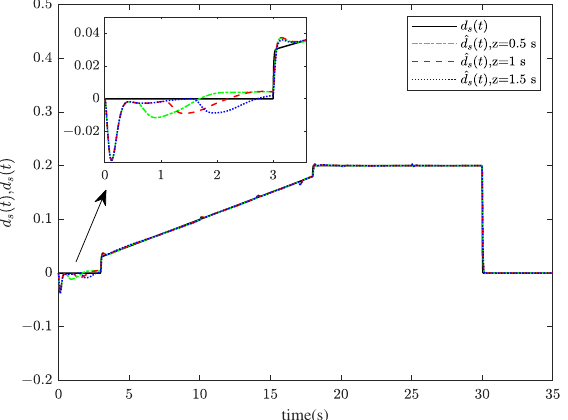
Figure 8. The measurement noise disturbance d s ( t ) and its estimation ˆ d s ( t )